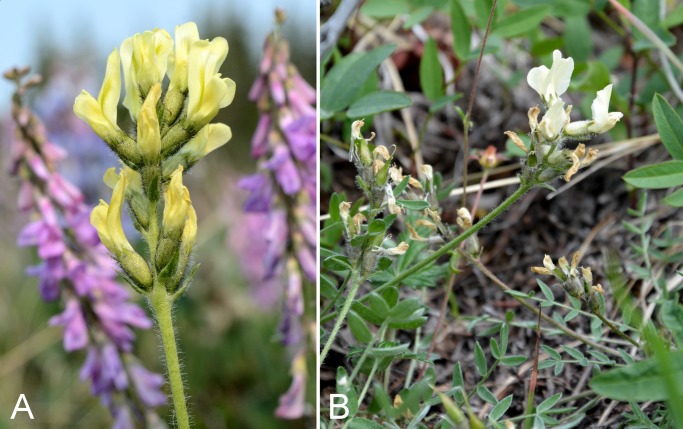
Oxytropis maydelliana and Oxytropis varians.Oxytropis maydelliana: (A) inflorescence, Saarela et al. 3154. Oxytropis varians: (B) inflorescence, Saarela et al. 4212. Photographs by R. D. Bull (A) and P. C. Sokoloff (B).